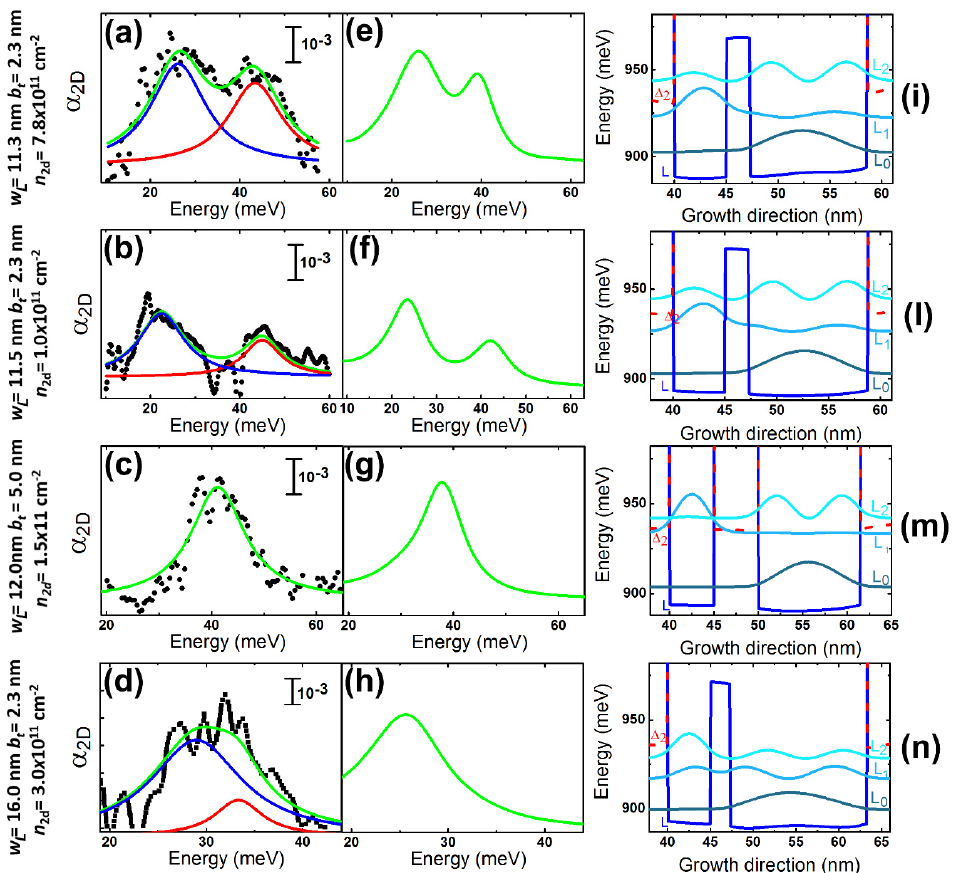
Figure 4. ( a − d ) Experimental intersubband (ISB) absorption measured by FTIR (black dots) with Lorentzian fits of the resonances centered at E abs (blue curve) and E abs (red curve). The green curve is the sum of the blue and red fit curves. ( e – h ) Corresponding calculated absorption spectra. ( a , e ) Sample 2218; ( b , f ) Sample 2219; ( c , g ) Sample 2224; ( d , h ) Sample 2267. ( i – n ) Calculated squared envelope wavefunctions for sample ( i ) 2218, ( l ) 2219, ( m ) 2224, ( n ) 2267.